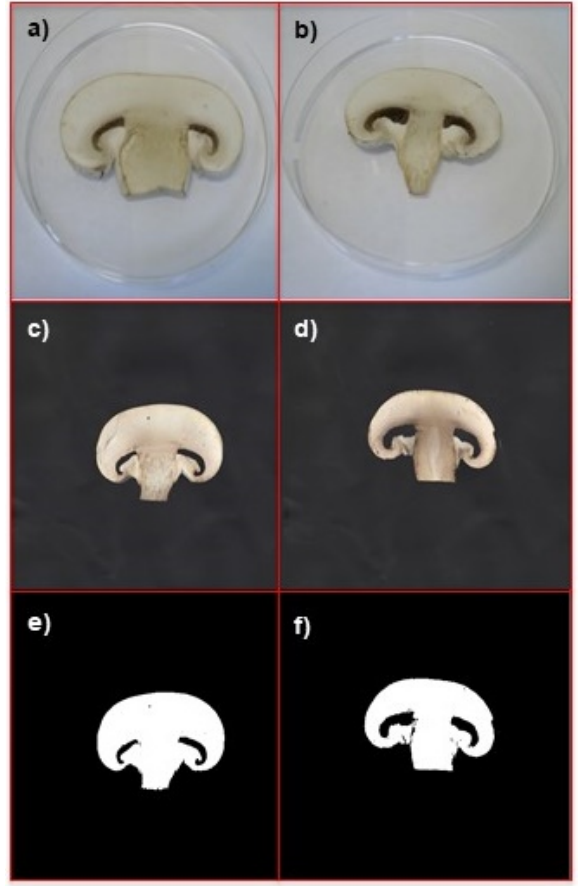
Figure 3. Comparison of different mushroom samples, all of them collected after 8 days: ( a ) image of a sample protected with green tea + α -tocopherol; ( b ) image of a blank sample; ( c ) scan of a sample protected with green tea + α -tocopherol; ( d ) scan of a blank sample after 8 days; ( e ) segmentation of a sample protected with green tea + α -tocopherol; ( f ) segmentation of a blank sample. Images ( a , b ) were captured with a Nikon Coolpix 4300 digital camera positioned at a height of 15 cm and a 45° angle, upper lighting (6500 K diffuse fluorescent light), with the following settings: manual mode; no flash; macro close-up (focus mode); fine image quality; 1600 image size; ISO auto (sensitivity). Images ( c – f ) were captured with the Epson Stylus DX3800 scanner.